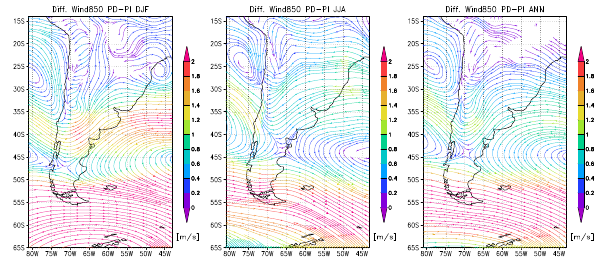
Fig. 10. Differences in Wind at 850hPa between present-day and Figure 10 : Differences in Wind at 850 hPa between present-day and pre-industrial times. pre-industrial times. Colours indicate differences in wind velocities. Colours indicate differences in wind velocities. left: DJF; middle: JJA; right: annual. Left: DJF; middle: JJA; right: